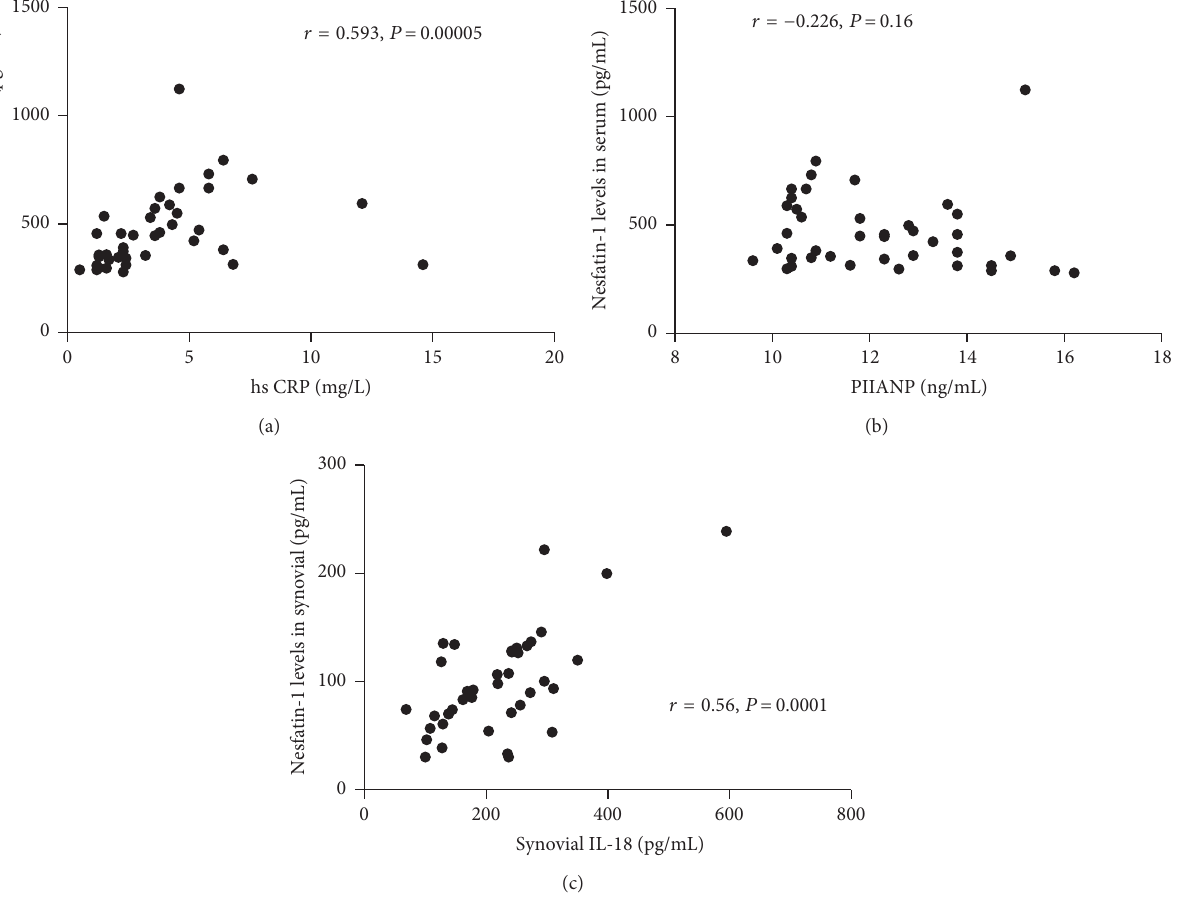
Figure 5: The relationships between serum nesfatin-1 levels and serum hsCRP, PIIANP levels and between synovial nesfatin-1 levels and synovial IL-18 levels. (a) A strong and statistically significant correlation was found between serum nesfatin-1 and hsCRP levels in OA patients ( 𝑟 = 0.593 , 𝑃 = 0.00005 ); (b) there was no statistical correlation between serum nesfatin-1 and PIIANP levels ( 𝑟 = −0.226 , 𝑃 = 0.16 ); (c) statistically significant correlation was found between synovial nesfatin-1 and IL-18 levels 𝑟 = 0.560 , 𝑃 = 0.0017 .